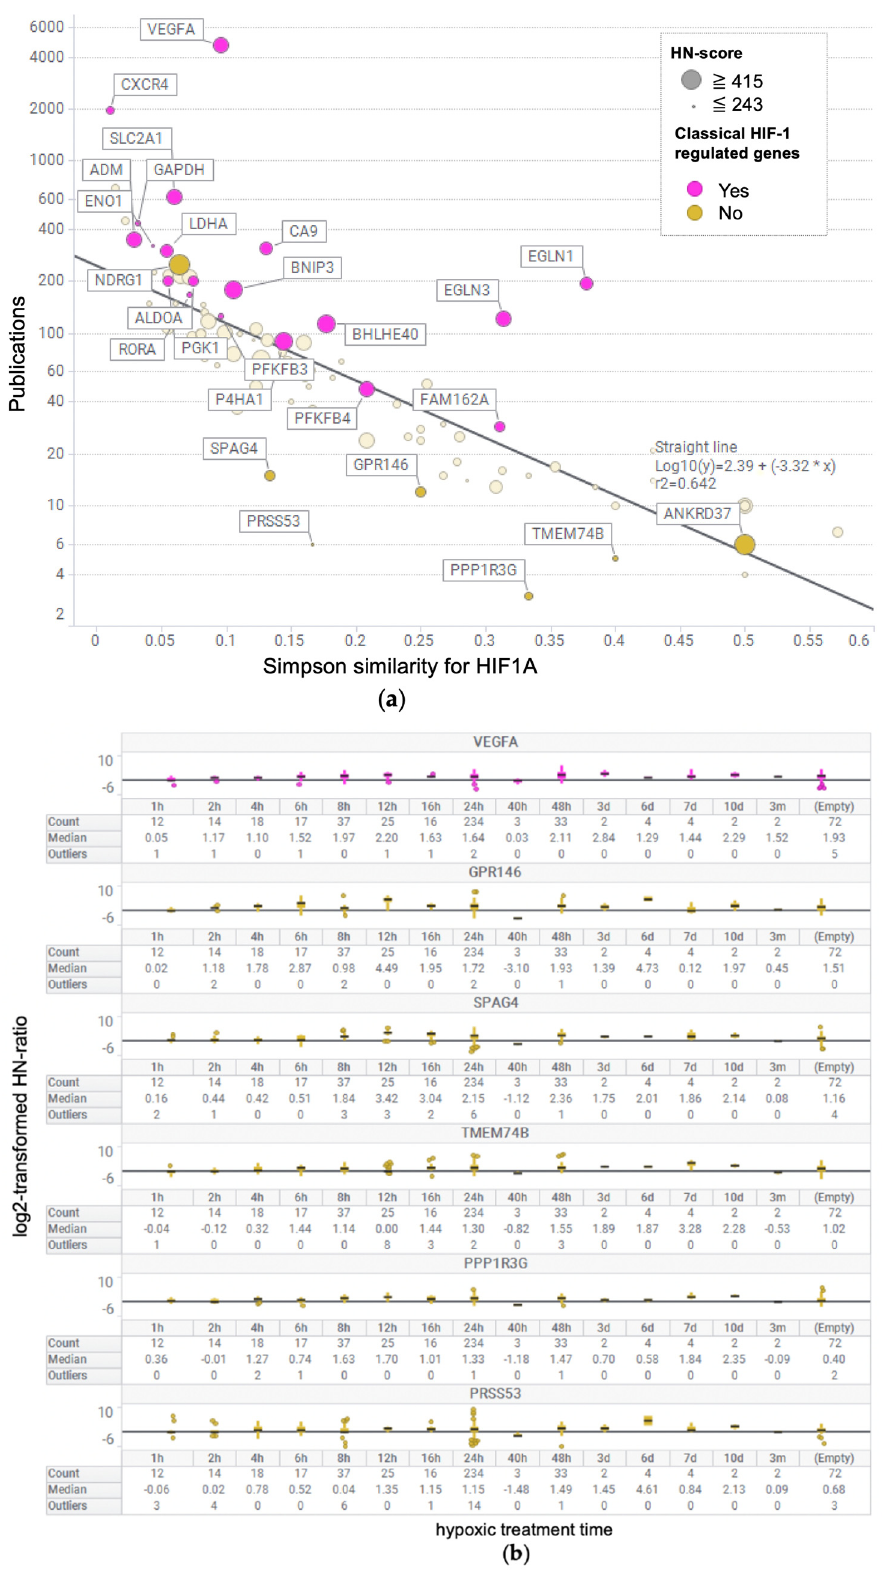
Figure 3. Discovery of novel genes associated with hypoxic stimulus-response. ( a ) Scatter plot of the number of publications vs. Simpson similarity coefficients for HIF1A in the UP 100 gene list. In this scatter plot, genes that were reported to be associated with HIF-1 15 years ago were marked as “known genes regulated by HIF-1”. ( b ) Box plot of log2-transformed HN-ratio per hypoxic treatment time for some of the UP 100 genes.